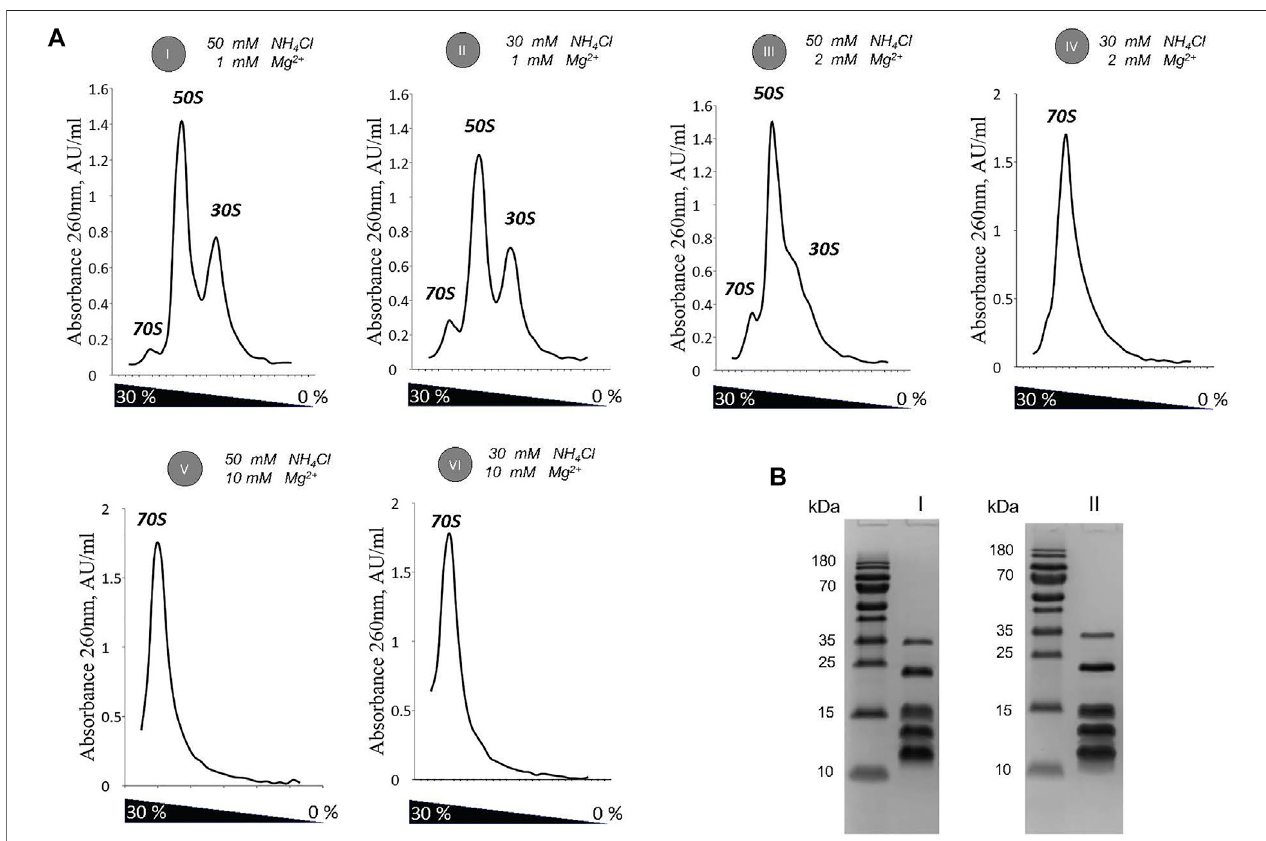
FIGURE 1 | Optimization of 30 S subunit puri fi cation by titration of Mg 2+ / NH 4 Cl ratio. ( A) Sucrose gradients pro fi les of the 70 S sample exposed to mild dissociation conditions (I – IV), and association conditions (V-VI). (B) SDS-PAGE of 30 S puri fi ed at conditions determined as optimal (1 mM Mg / 30 mM NH 4 Cl) in absence (I) and presence (II) of